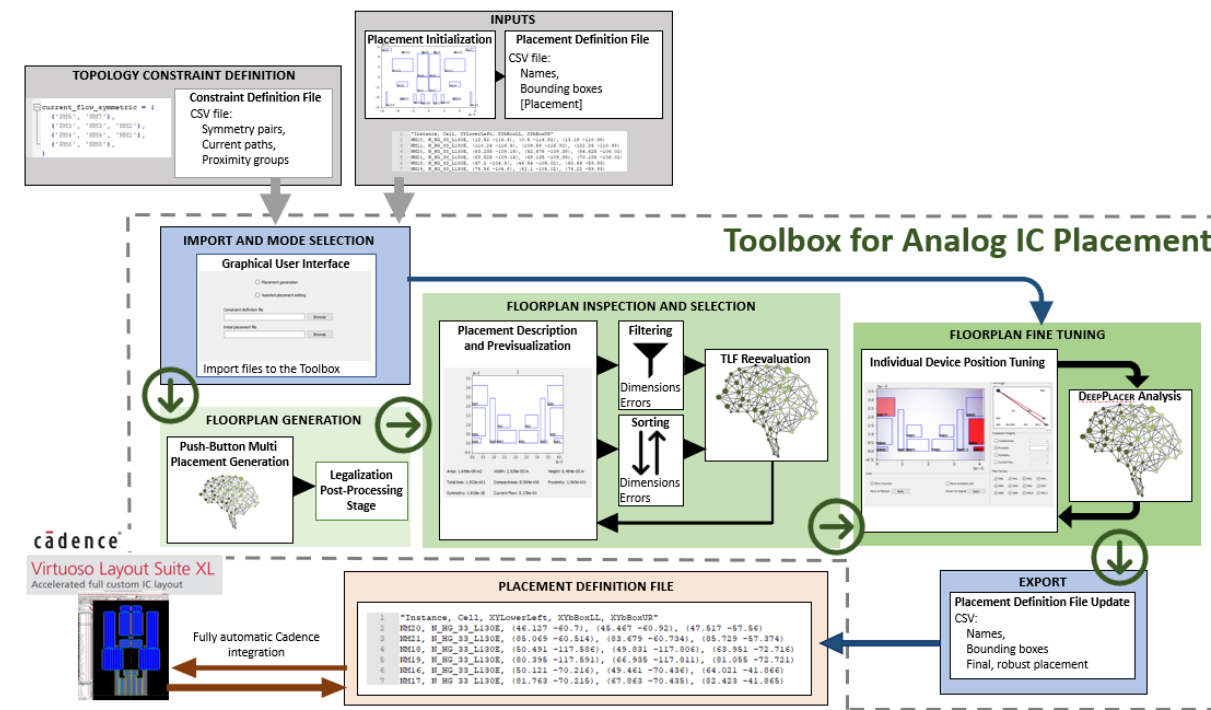
Figure 1. High ‐ level synthesis flow of the proposed toolbox based on advanced DL techniques. Figure 1. High-level synthesis flow of the proposed toolbox based on advanced DL